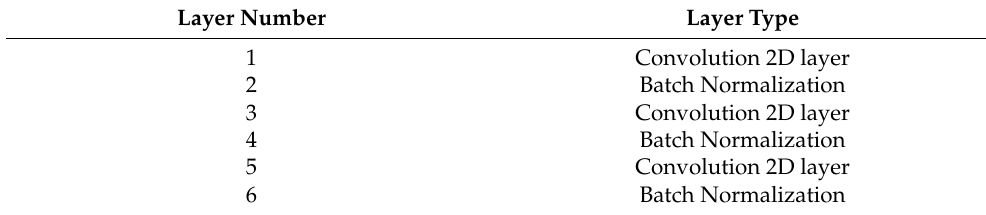
Table 2. Basic Layer (BL) processing model.